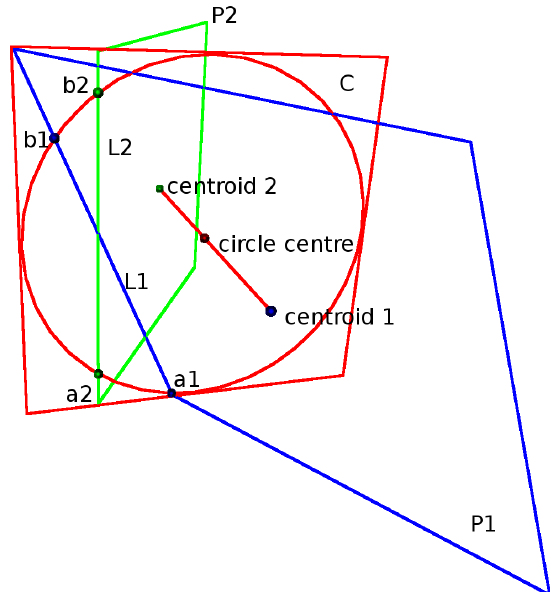
Figure 3. Plane P1 and plane P2 are derived from point clouds with Centroid 1 and Centroid 2. An intersecting plane C with a circle is positioned in between the two point cloud centroids. L1 is the intersecting line between plane P1 and plane C. L2 is the intersecting line between plane P2 and plane C. a1 and b1 are the intersecting points between the circle and L1. a2 and b2 are the intersecting points between the circle and L2. A measure of how well the two planes connect is evaluated by measuring the distances from points a1,b1 and a2, b2 to the opposite intersecting